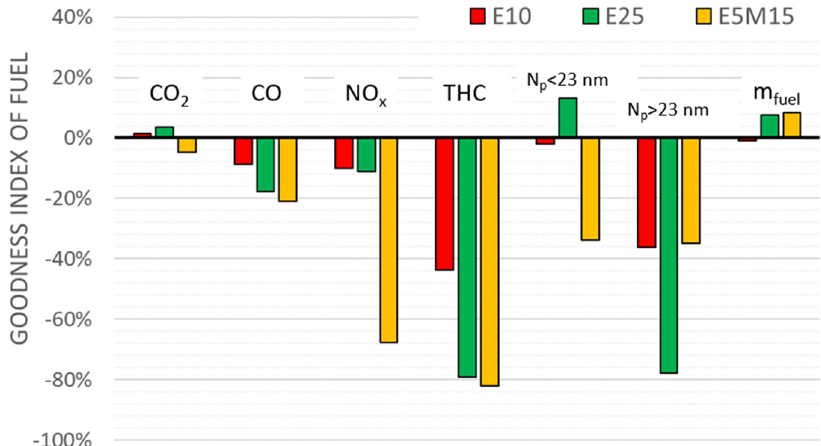
Figure 11. Goodness index based on fuel consumption and emissions for gasoline, E10, E25 and E5M15.